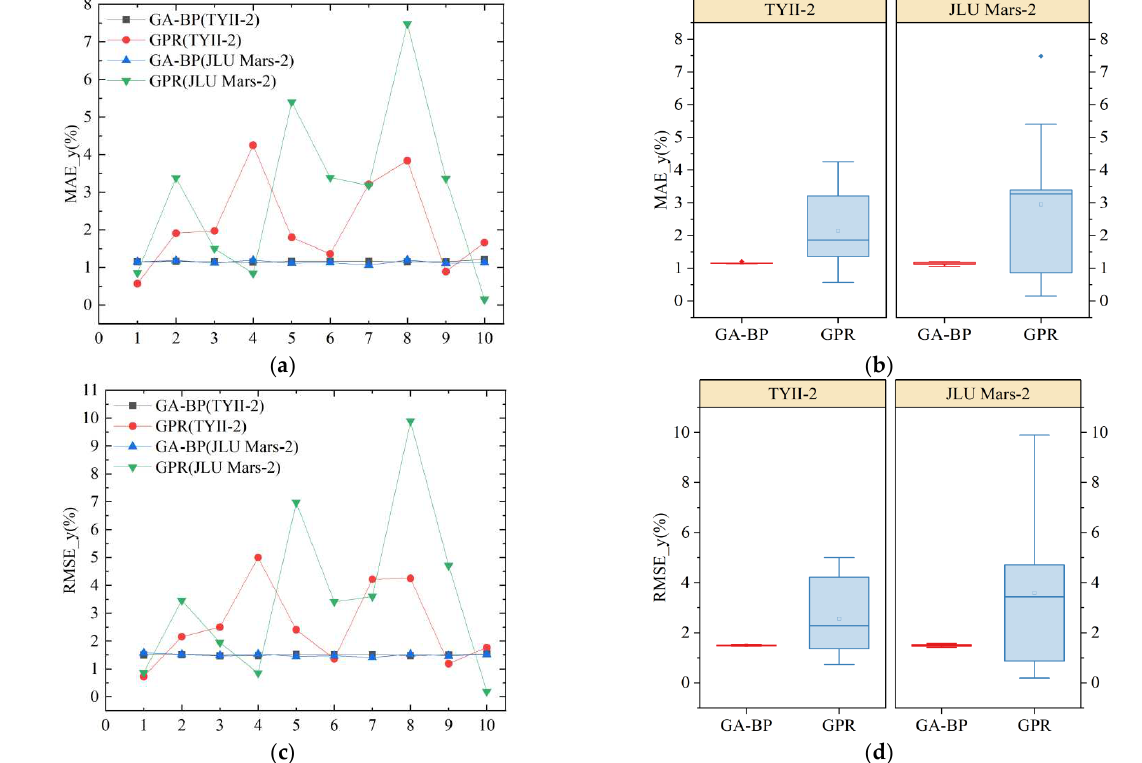
Figure 9. The estimation results of five test groups for slip_ y using GA-BP and GPR: ( a ) the line charts of MAE_ y ; ( b ) the box plots of MAE_ y ; ( c ) the line charts of RMSE_ y ; ( d ) the line charts of RMSE_ y .